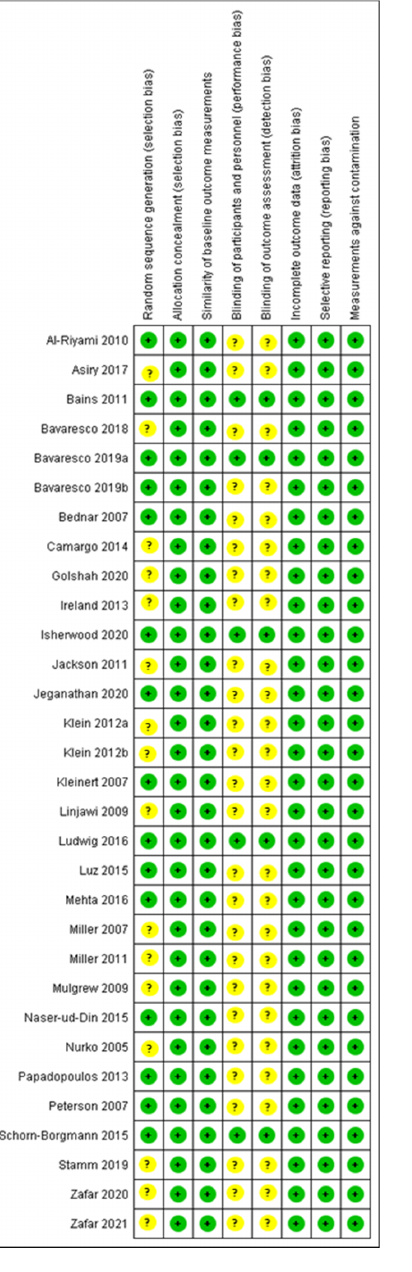
Figure 7. General summary of the risk of bias assessment of the included studies.